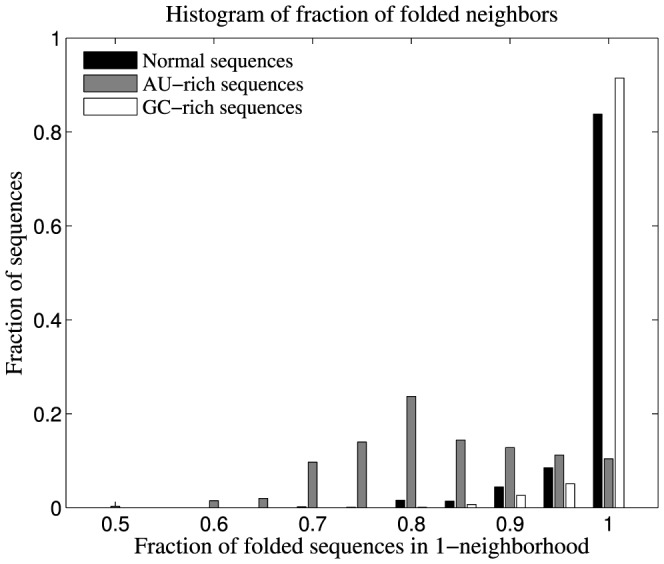
Comparison of 1-neighbourhoods of sequences of varied GC-content.Data shown are the histogram of fractions of folded sequences in 1-neighbourhood for each of 1000 randomly chosen normal, AU-rich (GC content ≤20%) and GC-rich (GC content ≥80%) sequences. We observe that a majority of AU-rich sequences have a lower fraction of folded neighbours, compared to normal sequences and GC-rich sequences, in their 1-neighbourhood. The sequences were folded using viennaRNAFold routine of Vienna RNA package [10].